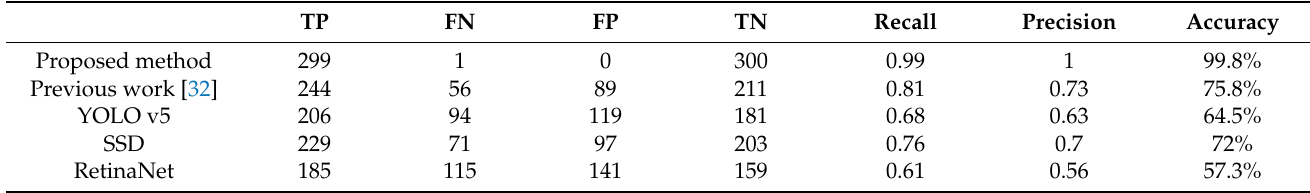
Table 3. Quantitative comparison results (dotted defect